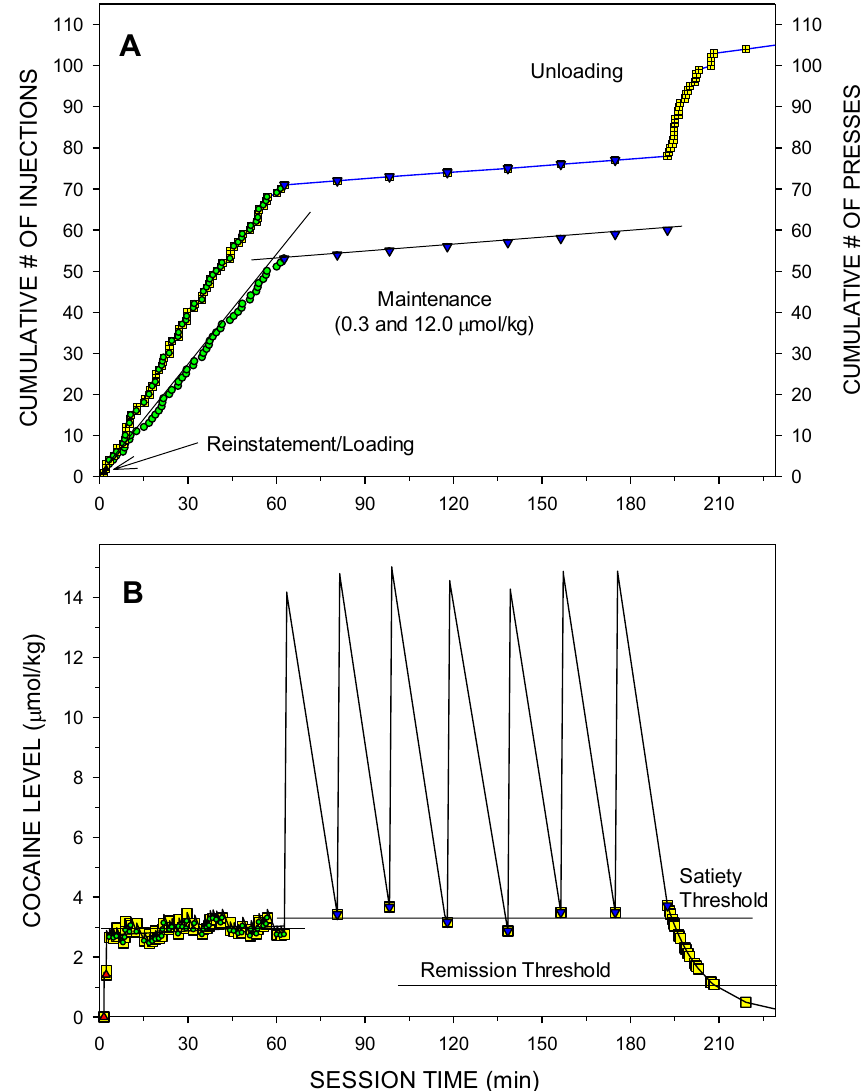
Figure 1. Cumulative records of events ( A ) and the calculated levels of cocaine at the time of each event ( B ) during a representative Baseline FR1 session. There were two kinds of events: lever presses (right y -scale) and drug injections (left y -scale). Red triangles represent loading injections. Yellow squares represent each active lever press. ( A ) Each symbol represents an event and the horizontal distance between each event represents an inter-event interval. The mean ± SEM inter-injection intervals were 71 ± 7 s and 1113 ± 25 s at the cocaine unit doses of 0.3 (green circle) and 12.0 (blue inverted triangle) µmol/kg, respectively. Both the inter-press and inter- injection intervals were very regular during the FR1 maintenance phase as demonstrated by the linear regression lines. The last inter press interval was 652.8 s (10.9 min), i.e. longer than the critical interval of 7.5 min 21 . The unloading phase duration was 15.7 min and the terminal local rate of lever-pressing was LR term = 1.59 presses/ min. ( B ) The zig-zagging line represents the calculated level of cocaine in the body at every second of the session. Horizontal lines represent mean ± SEM D ST = 2.92 ± 0.03 µmol/kg and D ST = 3.41 ± 0.11 µmol/kg at unit doses of 0.3 (green circle) and 12.0 (blue inverted triangle) µmol/kg, respectively, and the D RT = 1.08